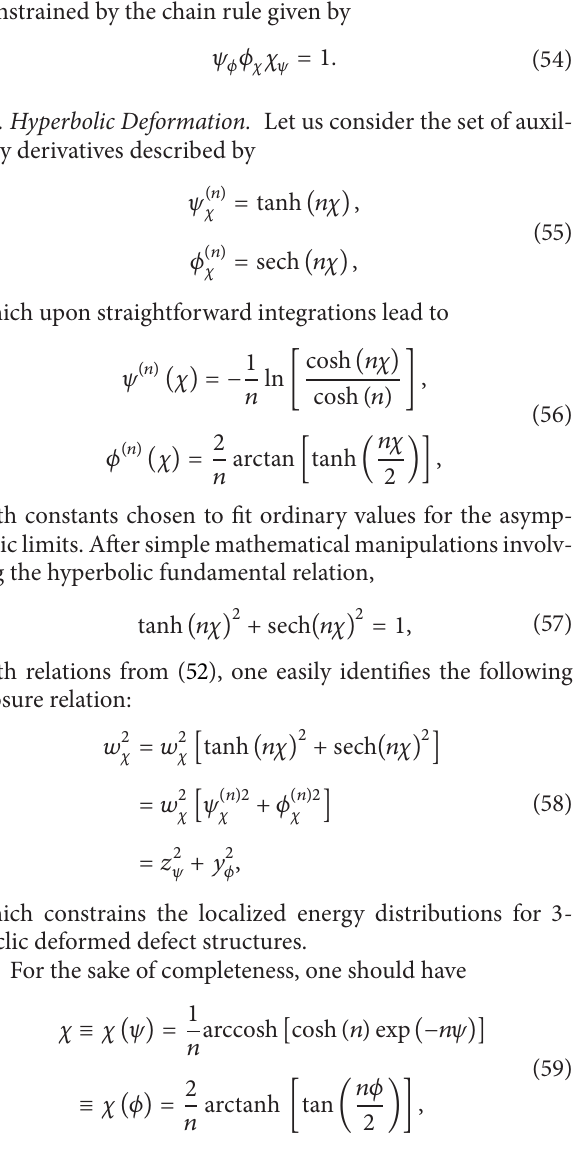
Figure 2: Total energy of localized solutions (topological masses) as function of the parameter 𝑛 . The results for 𝑀 family (dotted line), obtained from 𝜓 (𝑛) (𝜙) = 𝑦 (1/𝑛) 𝜙 , and for the second family (solid line), obtained from 𝜓 (𝑛) (𝜙) = ln (1 + 𝑦 𝜙 ) (1/𝑛) , are compared with preliminary results from [32] (dashed